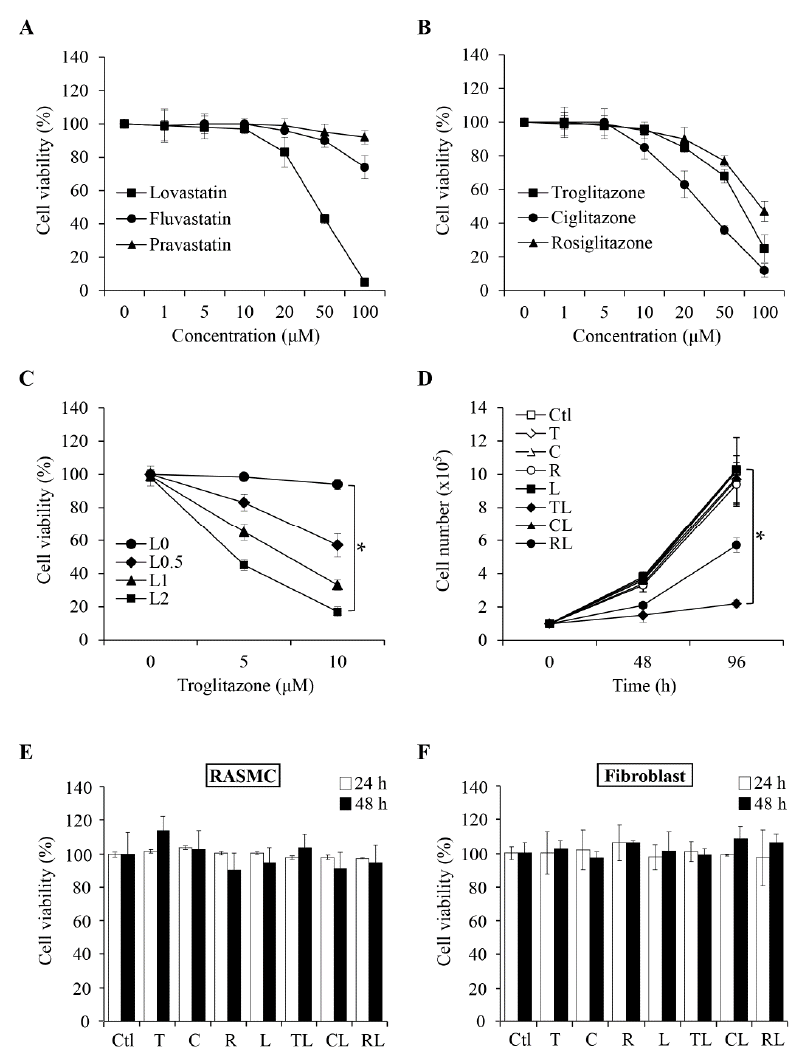
Figure 1. A synergistic effect in the anti ‐ proliferation activity of troglitazone and lovastatin. ( A ) Concentration responses of three statin derivatives in suppressing proliferation in SW1736 cells. ( B ) Concentration responses of three thiazolidinediones (TZDs) derivatives in SW1736 cells. ( C ) Monitoring the anti ‐ proliferation effect of troglitazone in combination with lovastatin. Cells were treated with troglitazone (5 and 10 μ M) in combination with lovastatin (labeled L, 0.5, 1, and 2 μ M). ( D ) Monitoring the proliferation rates in SW1736 cells treated with different combinations of indicated drugs. Concentrations used were defined previously. Single agents (T, C, R, and L): 10 μ M except L (2 μ M). Combination (TL, CL, and RL): TZDs (10 μ M) plus L (2 μ M). Cells were treated for 48 h and 96 h, and then analyzed by trypan blue staining. ( E , F ) Lack of anti ‐ proliferation effect in normal RASMC ( E ) and human gingival fibroblast cells ( F ). Cells were treated with indicated drugs as used in ( D ) for 24 and 48 h. Proliferation was analyzed by 3 ‐ (4,5 ‐ Dimethylthiazol ‐ 2 ‐ yl) ‐ 2,5 ‐ diphenyltetrazolium bromide (MTT) assay. Values represent the means ± S.E.M. ( n = 3). * p < 0.05. C: ciglitazone; CL: combination of ciglitazone and lovastatin; Ctl: control; L: lovastatin; R: rosiglitazone; RL: combination of rosiglitazone and lovastatin; T: troglitazone; TL: combination of troglitazone and lovastatin.